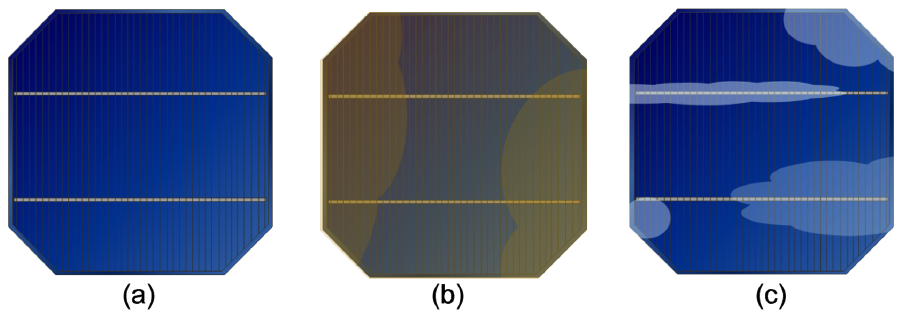
Figure 9. Degradation of PV module. ( a ) Ideal cell, ( b ) Discolouring effect, ( c ) Delamination